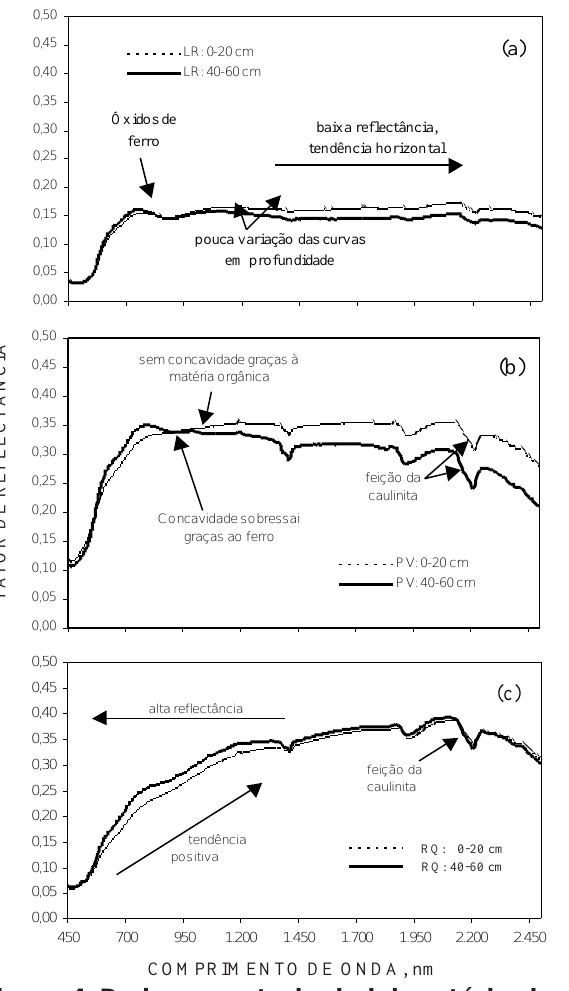
Figura 5. Curvas espectrais dos solos obtidas em laboratório, simulando as bandas do Landsat 5- TM (a) e curvas espectrais dos solos obtidas de dados do Landsat